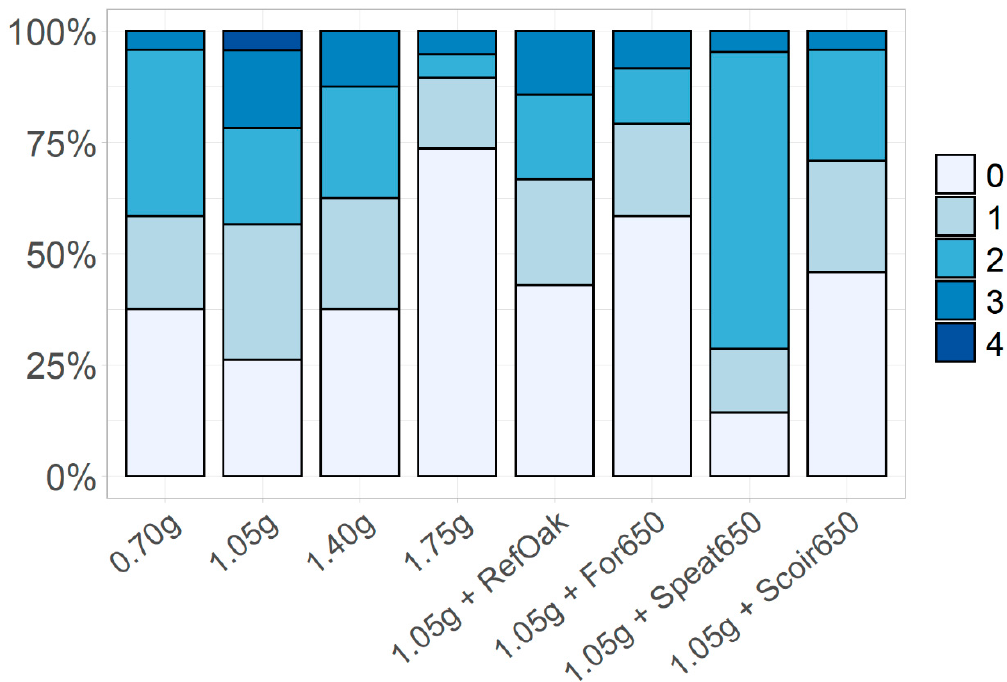
Figure 2. Botrytis cinerea infection score on strawberry plant leaves for 4 treatments with increasing fertilizer doses and 4 biochar treatments. The infection was scored with a value of 0 (no infection) to 4 (100% infected leaf) 7 days after infection.